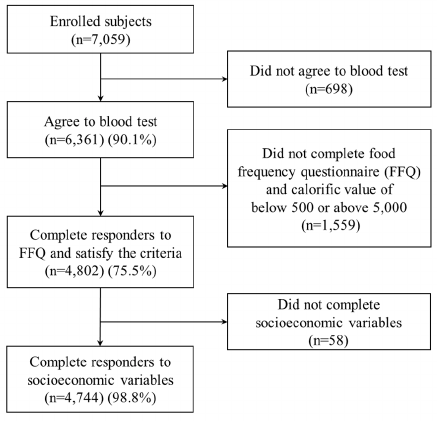
Figure 1. Selection of participants. Table 1. General Characteristics and Blood Lead Levels of the Study Population.